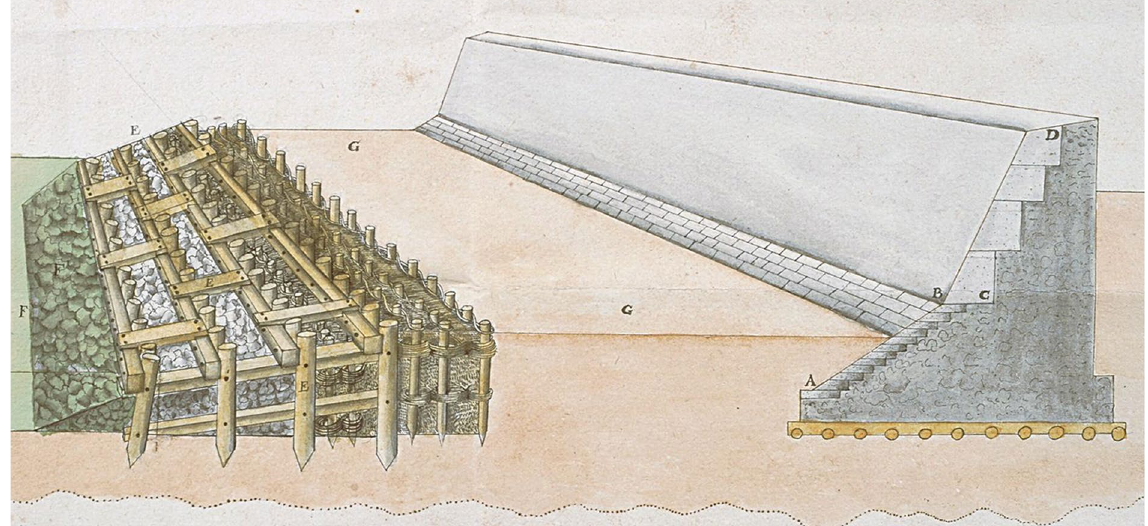
Fig. 5 Orthographic profile of the Wall that is determined to be built along the sea from the Bastion of Santa Catalina to the bastion of the Cross of the City of Cartagena. Arranged by S.M. and under the direction of the Field Master D. Juan de Herrera y Sotomayor, Military and Castilian Engineer of the Castle of S. Phelipe de Barajas by S.M. Year 1721. Taken from (Portal de Archivos Españoles (PARES)